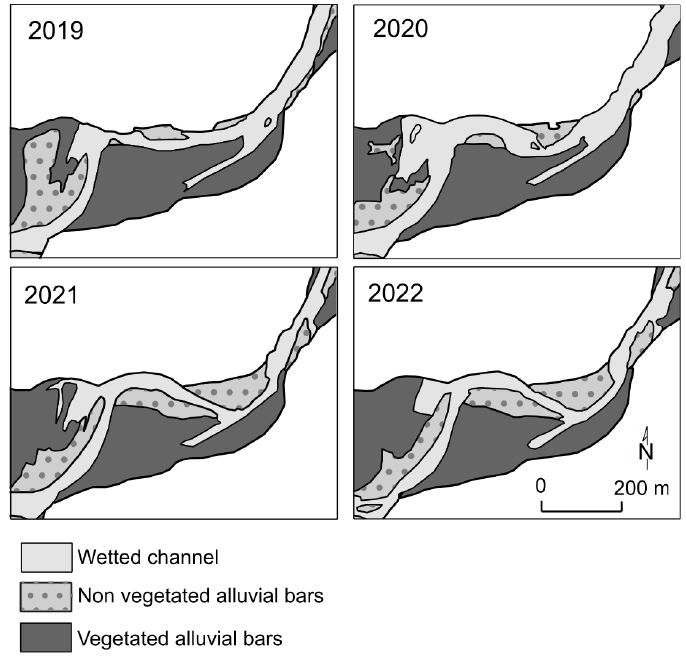
Figure 6. Planform evolution of Site 2 from 2019 to 2022.